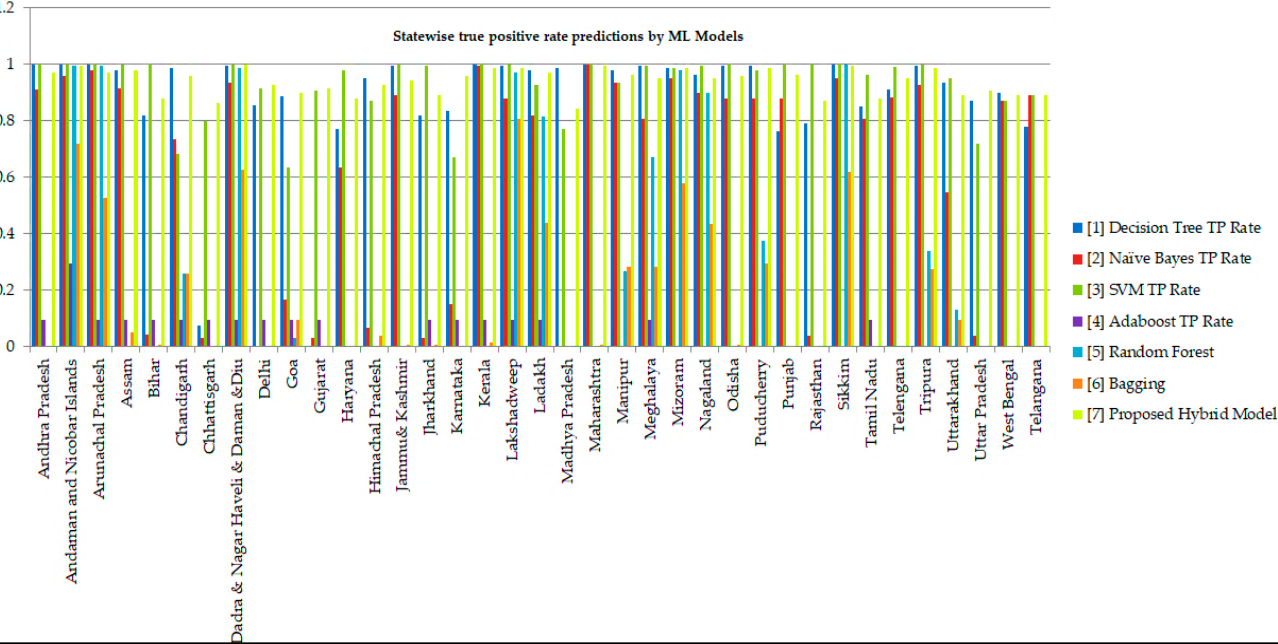
Figure 12. False Positive Rate Predicted by Classification Models for each class.